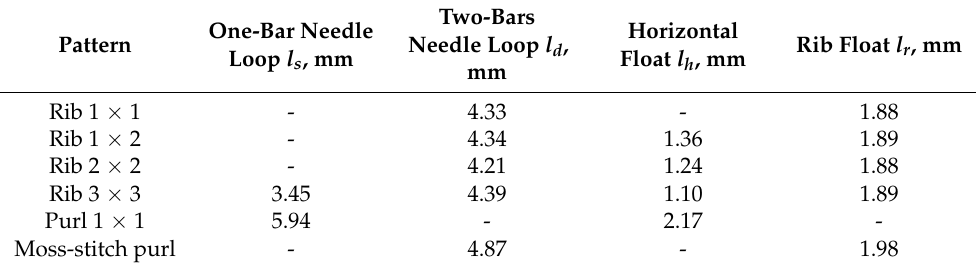
Table 3. Theoretically calculated lengths of structure